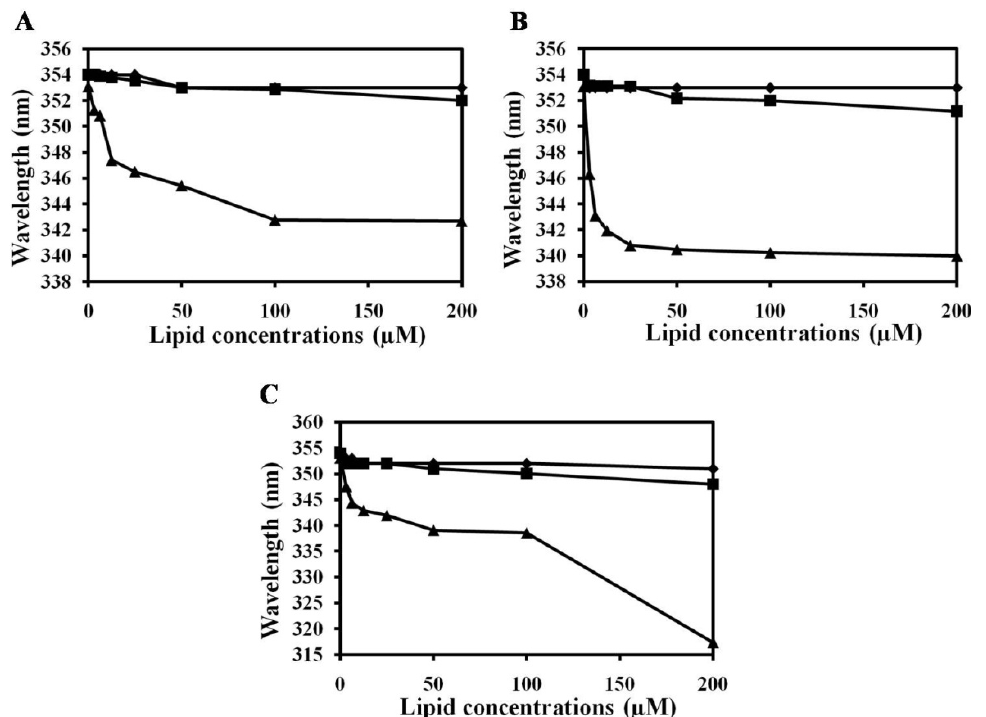
Figure 2. Blue shift in Trp fluorescence. Emission maxima from Trp in peptides in the presence of ( A ) PC; ( B ) PC:SM (2:1, w / w ); and ( C ) PC:CH (2:1, w /w). (KW) (KW) (squares), (KW) (triangles). 4 5